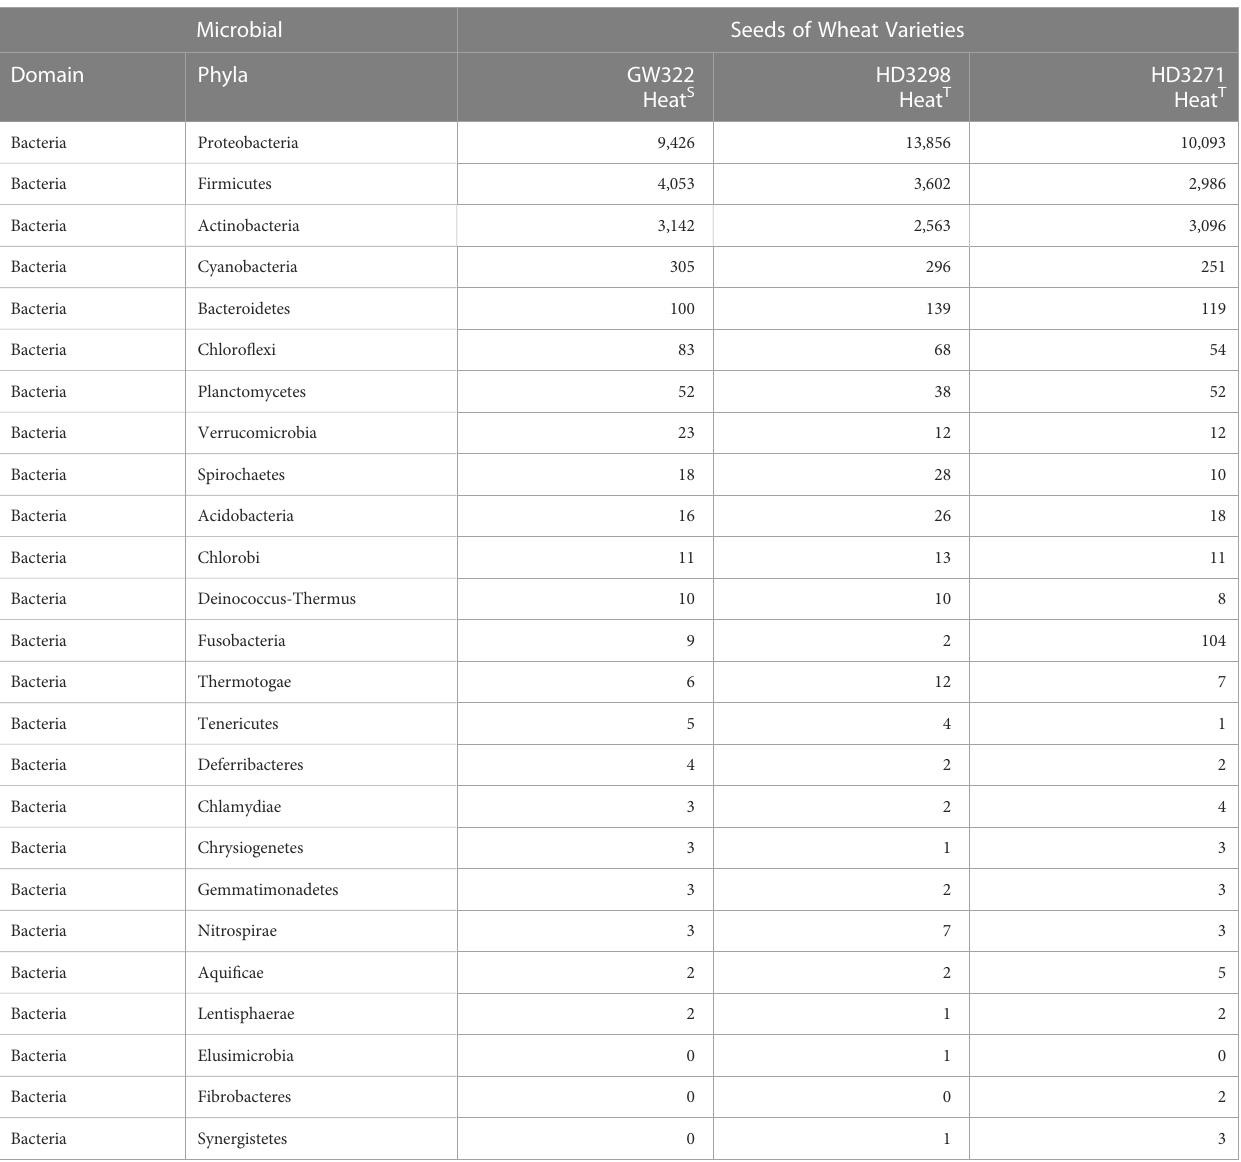
TABLE 4 Phyla-wise distribution of bacterial abundance among three varieties. Microbial Seeds of Wheat Varieties